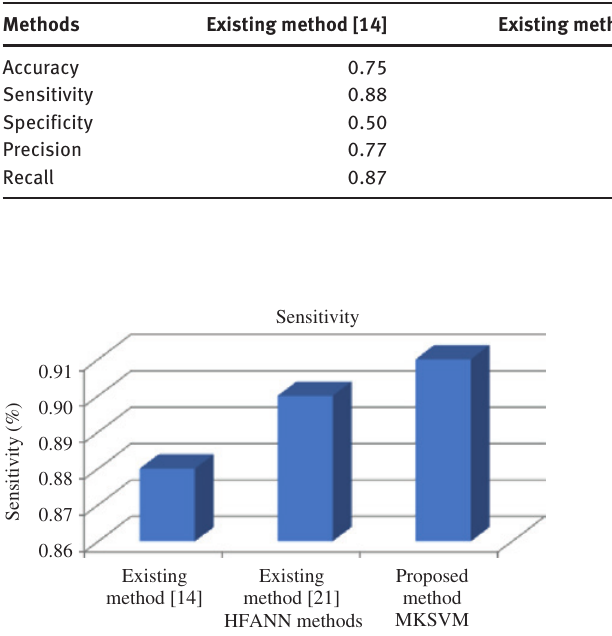
Figure 6: Comparative Analysis of